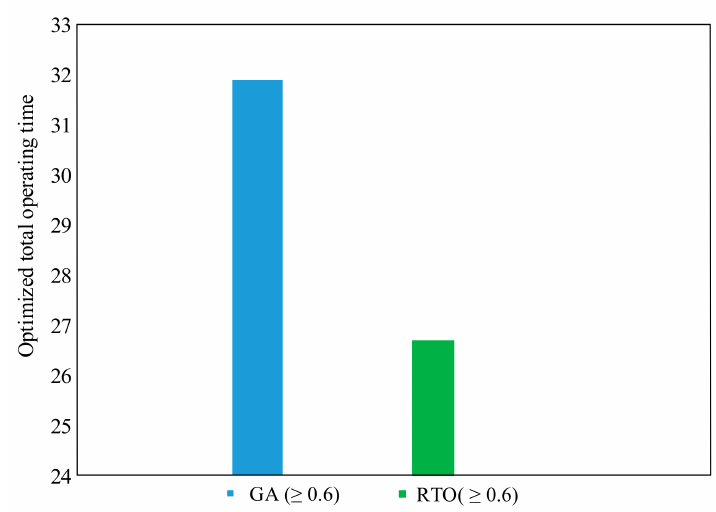
Figure 7. Optimized total operating time with the literature for Case 1.